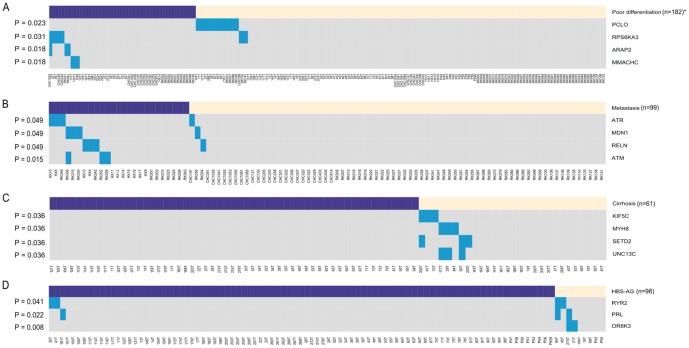
Overview of gene mutations and major associated clinical features, including A, Cell differentiation; B, Metastasis; C, Cirrhosis; and D, HBS-AG.The lower heatmap shows genes (rows) and tumors (columns) with mutations (blue). The purple (or yellow) boxes above the heatmap represent poor differentiation (or good differentiation), metastasis (or non-metastasis), cirrhosis (or non-cirrhosis) and HBS-AG positive (or HBS-AG negative), respectively. The P-value of each gene is indicated to the left. *n is the number of HCC patients with available clinical information.